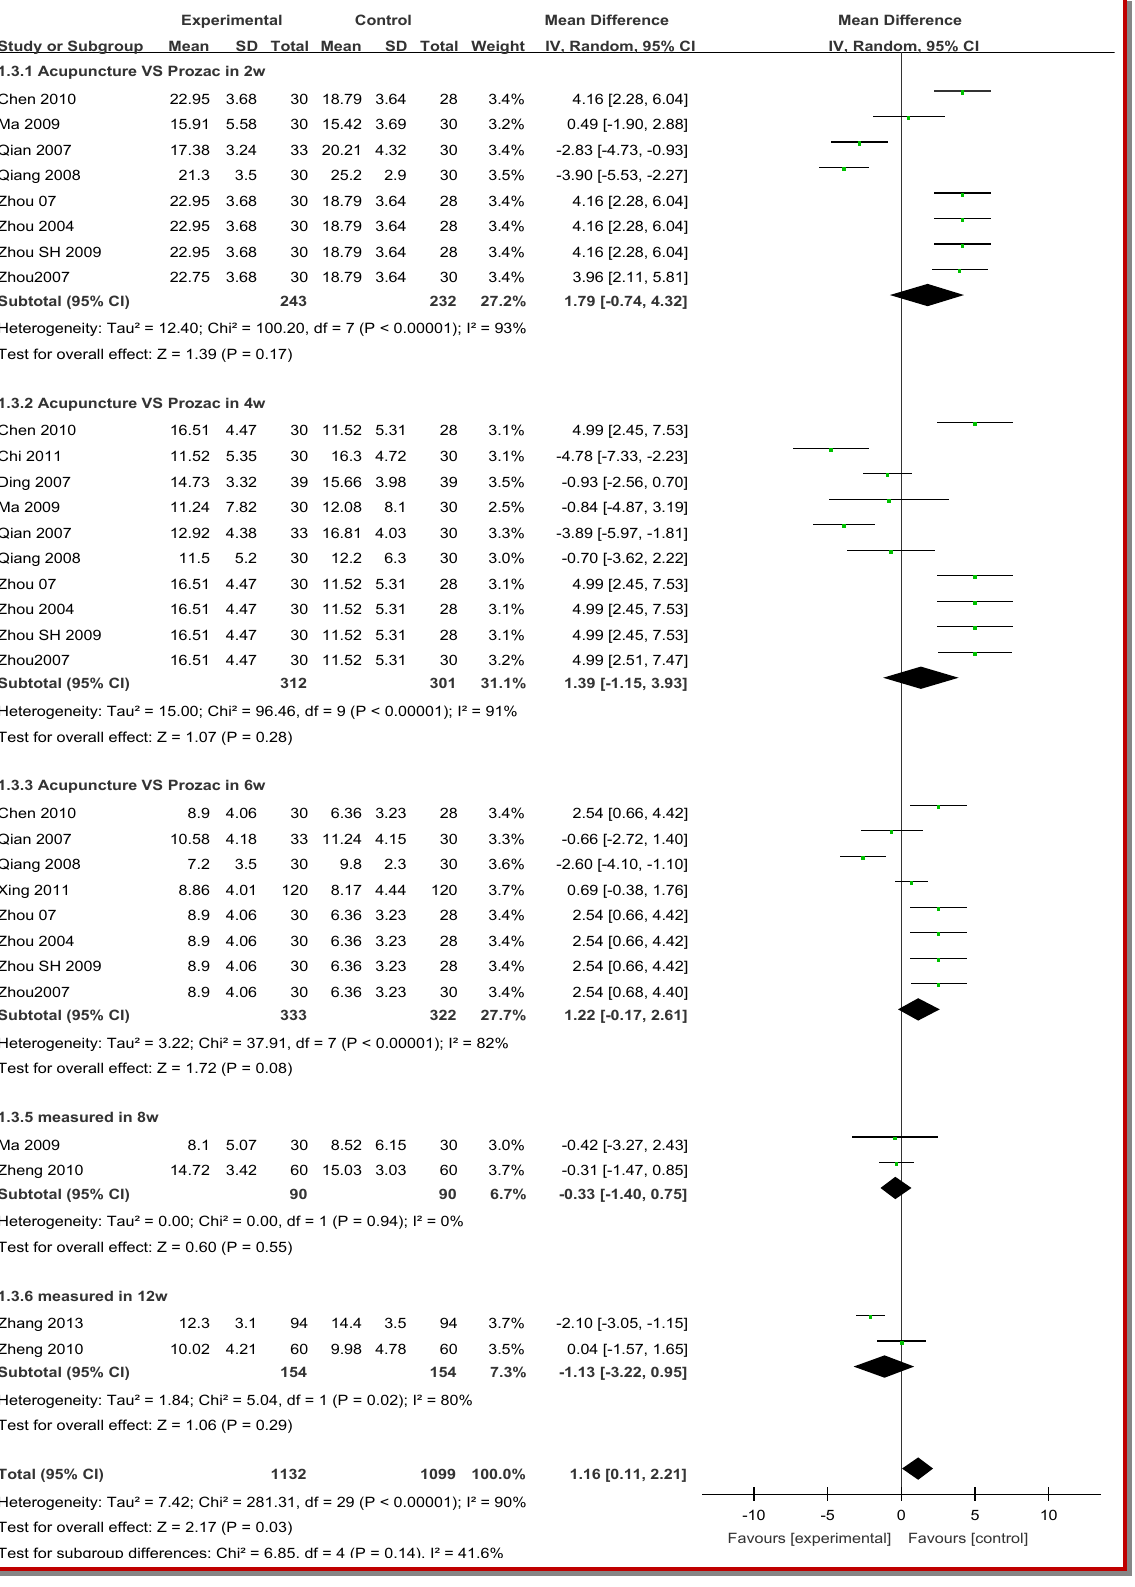
Figure 7: Meta-analysis of the studies evaluating HAMD scores of